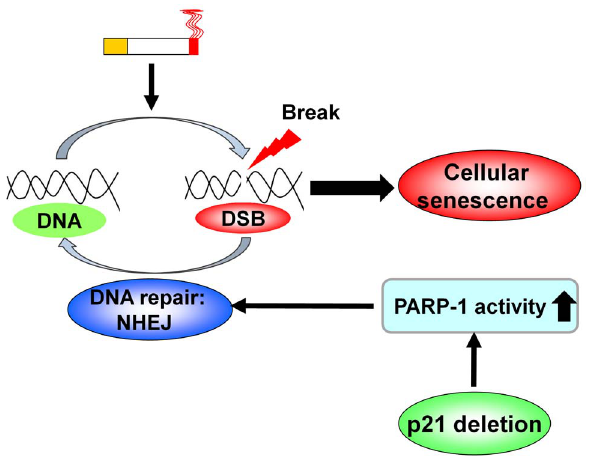
Figure 5. A schematic model showing the role of p21-PARP-1 in acute cigarette smoke (CS)-induced DNA damage and cellular senescence. CS exposure causes DNA damage including double- strand break (DSB). CS exposure also increases the level of p21, and p21 gene deletion augments PARP-1 activity and the levels of non- homologous end joining (NHEJ) proteins to repair damaged DNA. Consequently, CS-induced cellular senescence is attenuated by p21